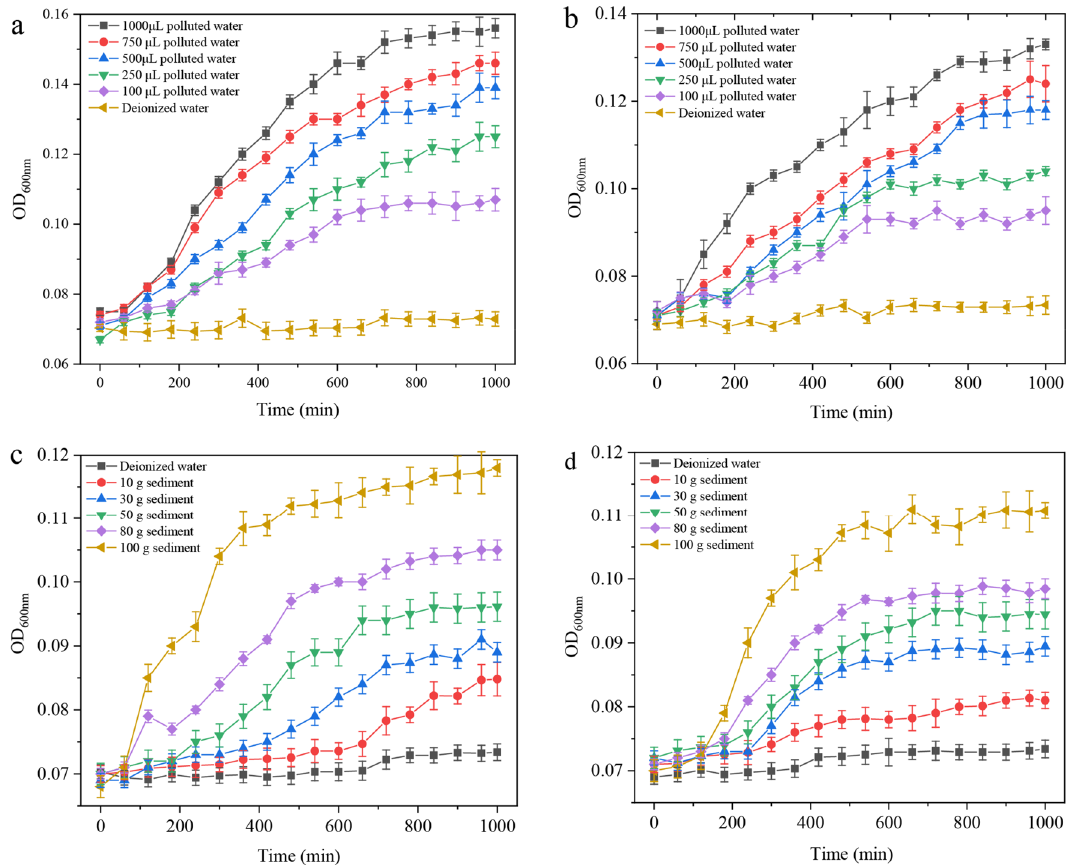
Figure 6. Growth of Staphylococcus aureus and Escherichia coli at different polluted river water concentrations ( a , b ) and different sediment mass additions ( c , d